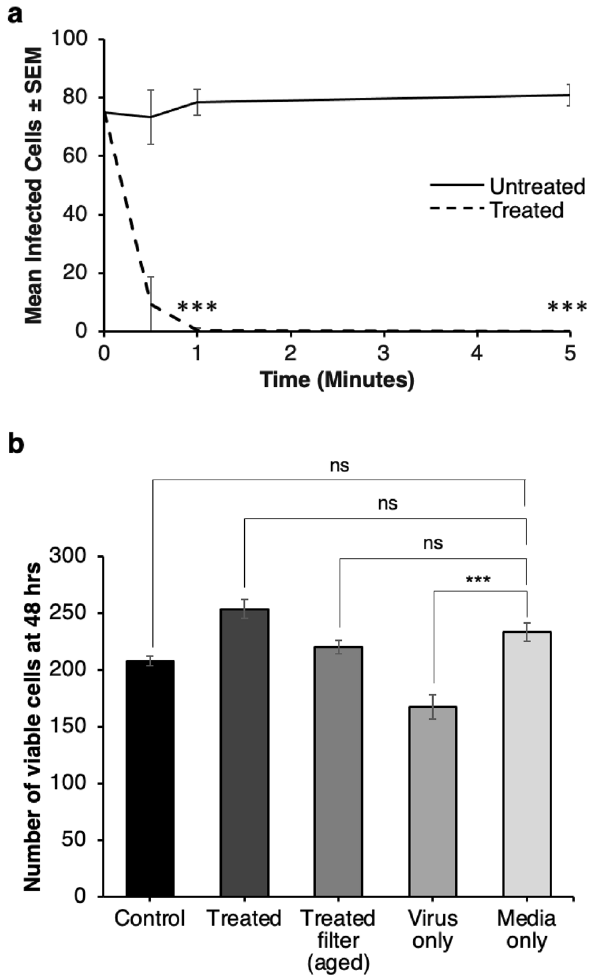
Figure 4. Antiviral efficacy of filters. ( a ) Time course showing SARS-CoV-2 inactivation at different time points following incubation on untreated and CHDG treated MK3 filters. *** denotes statistical significance < 0.001, n = 9) ( b ) Effect of filters on viability of Vero cells per field of view. 6 fields of view per well. Wells analysed in triplicate. n = 2. Error bars show standard error of the mean. ***p <